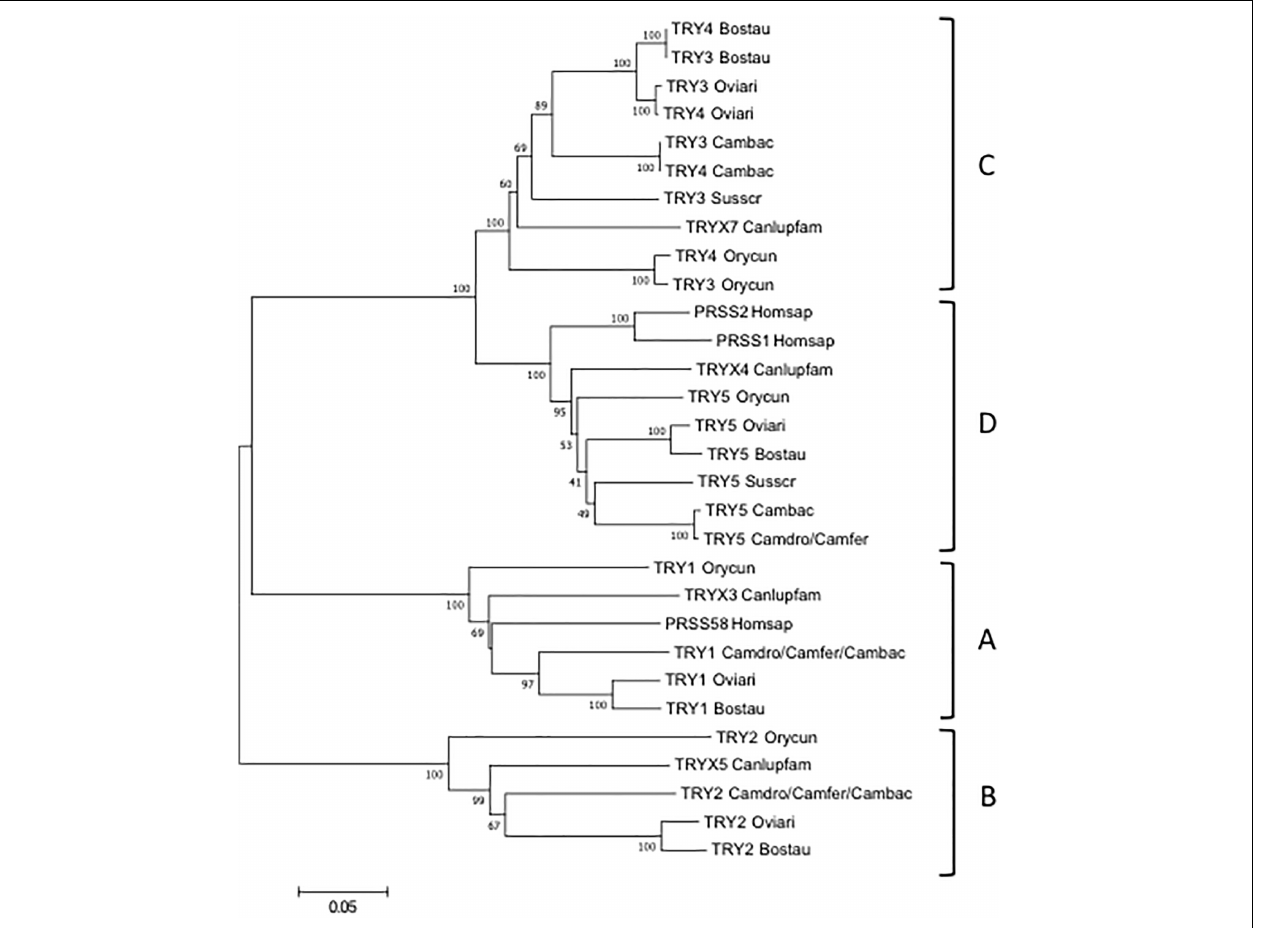
FIGURE 4 | The NJ tree inferred from the TRY gene sequences. The evolutionary analysis was conducted in MEGA7 (Kumar et al., 2016). The optimal tree with the sum of branch length = 1.55315431 is shown. The percentage of replicate trees in which the associated taxa clustered together in the bootstrap test (100 replicates) are shown next to the branches (Felsenstein, 1985). The tree is drawn to scale, with branch lengths in the same units as those of the evolutionary distances used to infer the phylogenetic tree. The evolutionary distances were computed using the p-distance method (Nei and Kumar, 2000) and are in the units of the number of base differences per site. The analysis involved 21 nucleotide sequences. Codon positions included were 1st+2nd+3rd+Noncoding. All positions containing gaps and missing data were eliminated. There were a total of 693 positions in the final dataset. The IMGT 6-letter for species (Homsap, Susscr, Bostau, Oviari, Camdro, Camfer, and Cambac) standardized abbreviation for taxon is